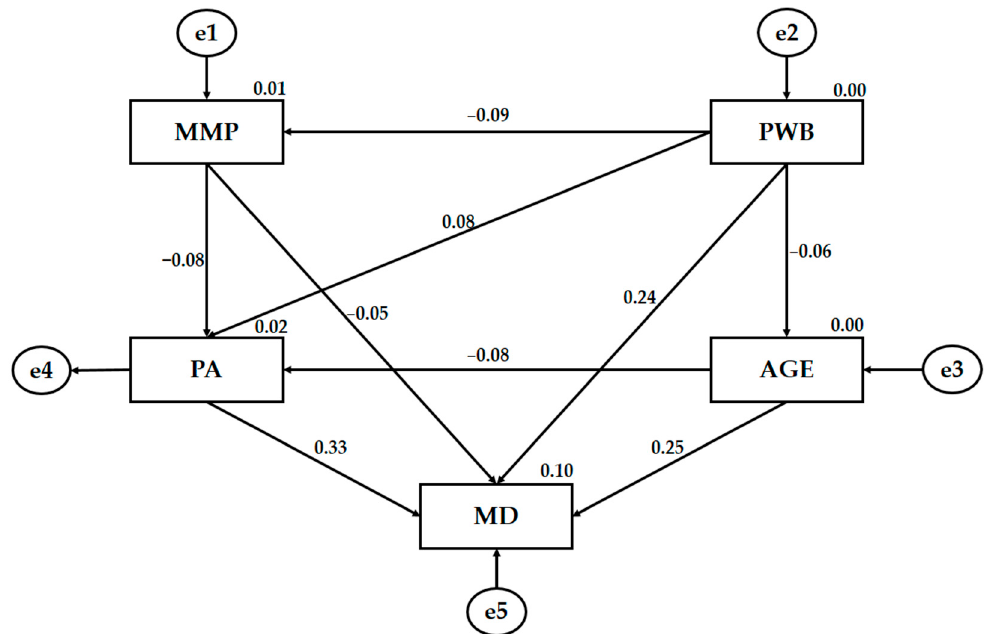
Figure 5. The structural equation for females. Note: Mass media pressure (MMP); Mediterranean diet (MD); physical activity (PA); psychological well-being (PWB); age (AGE); error (e). Table 3. The structural model for females.